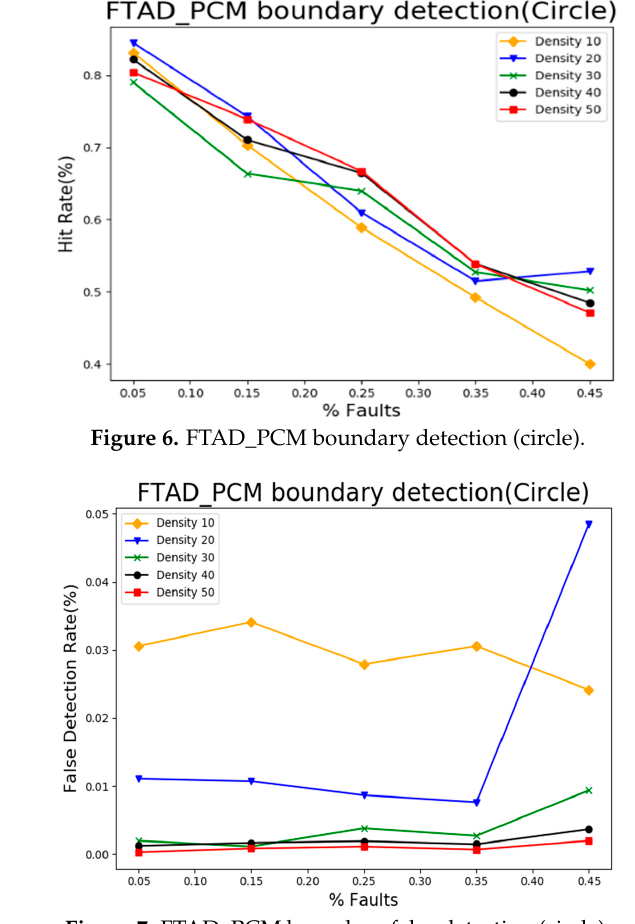
Figure 8. FTAD_PCM boundary detection (square).